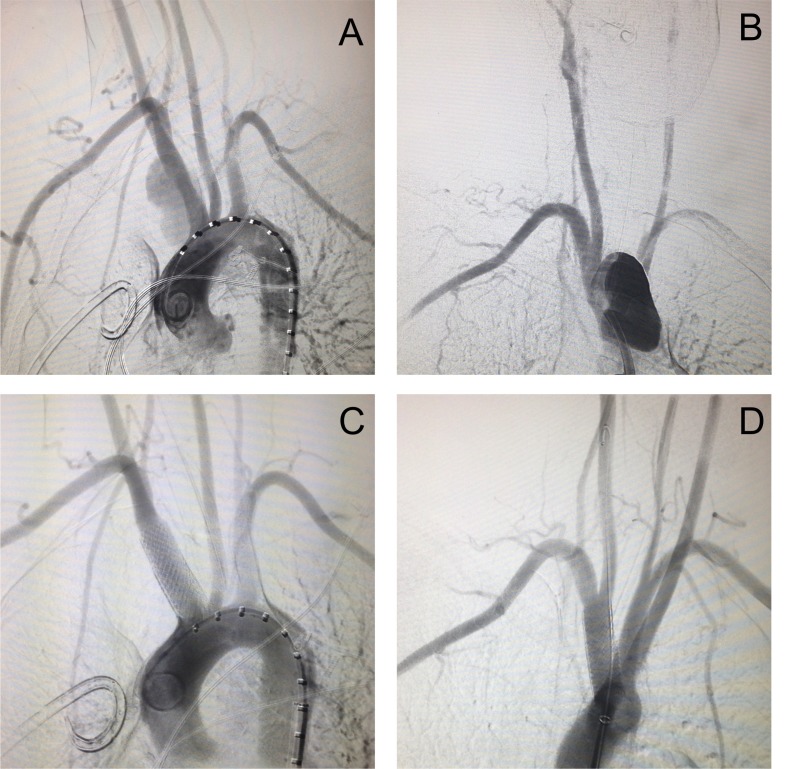
Images of endovascular treatment to repair an aneurysm of the brachiocephalic trunk with covered stents. Initial arteriography (A, B); Final arteriography (C, D).